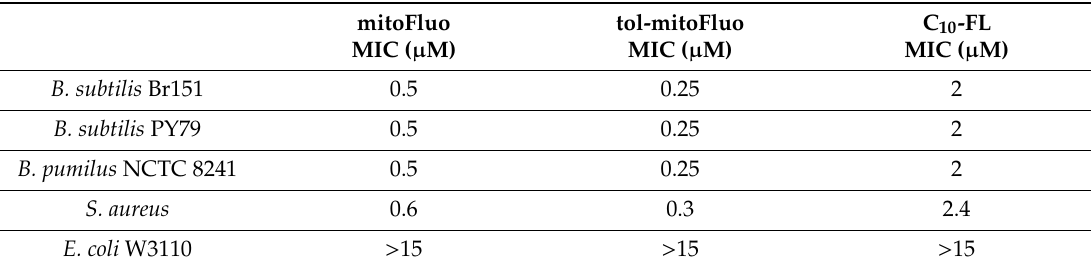
Figure 3. ( A – C ) The dose-dependent e ff ect of ( A ) tol-mitoFluo, ( B ) mitoFluo, or ( C ) C10-FL on the growth of Bacillus subtilis cells. The B. subtilis growth was evaluated by the absorbance at 620 nm at 37 ◦ C with a 96-well Multiskan FC Microplate Reader. ( D ) OD620 measurements of B. subtilis cells 20 h after the treatment with di ff erent concentrations of tol-mitoFluo, mitoFluo, C10-FL, FCCP, CCCP, and DNP. The gray dashed line shows the level of cell growth in control. The data points represent the mean ± SD of at least three experiments. Table 1. The susceptibility of various bacterial strains to the fluorescein derivatives: Minimal Inhibitory Concentration (MIC)